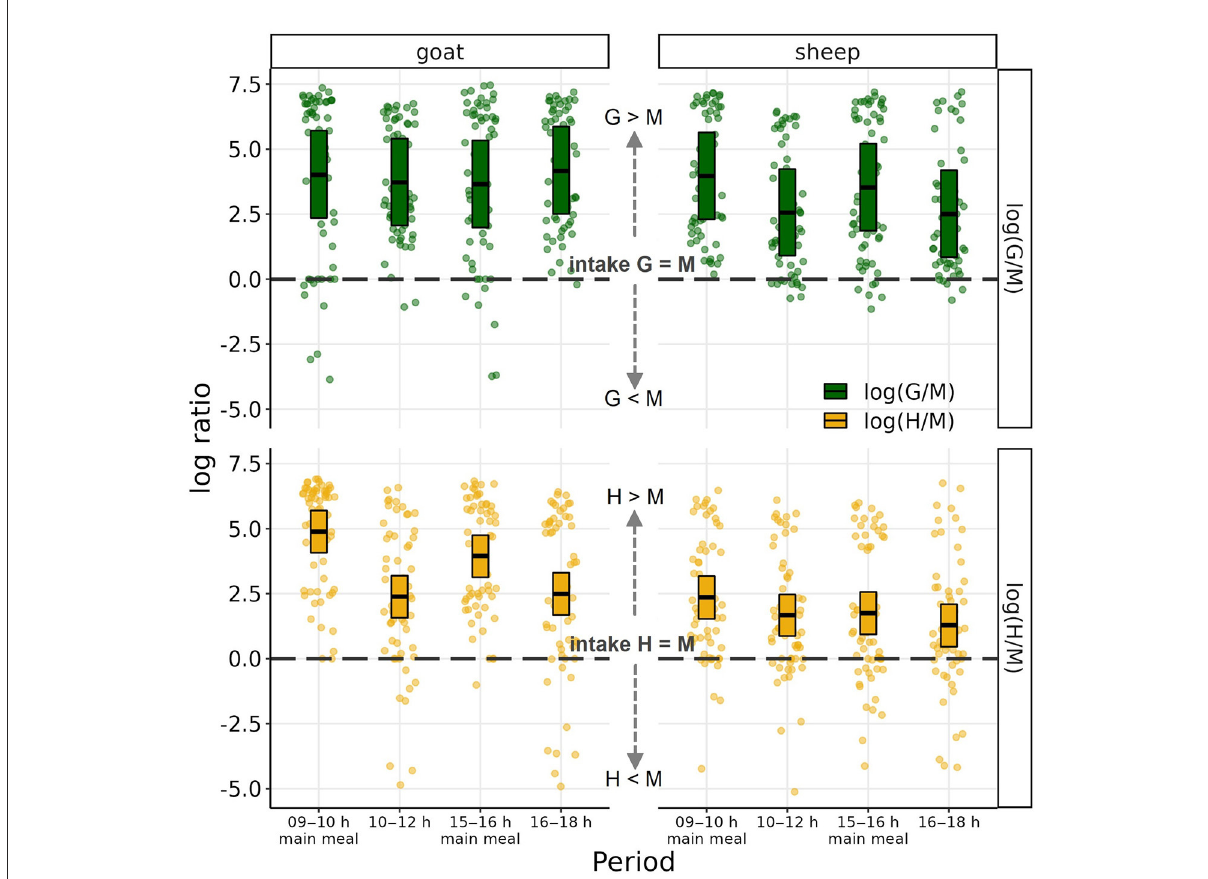
FIGURE4 Log ratios of dry matter (DM) intake of grass silage (G) to mixed ration (M) and of hay (H) to M by goats and sheep during the four observation time periods. Boxes represent population-level mean log ratios with bootstrapped 95% confidence intervals as estimated by the linear mixed-effects models. Dots represent observed log